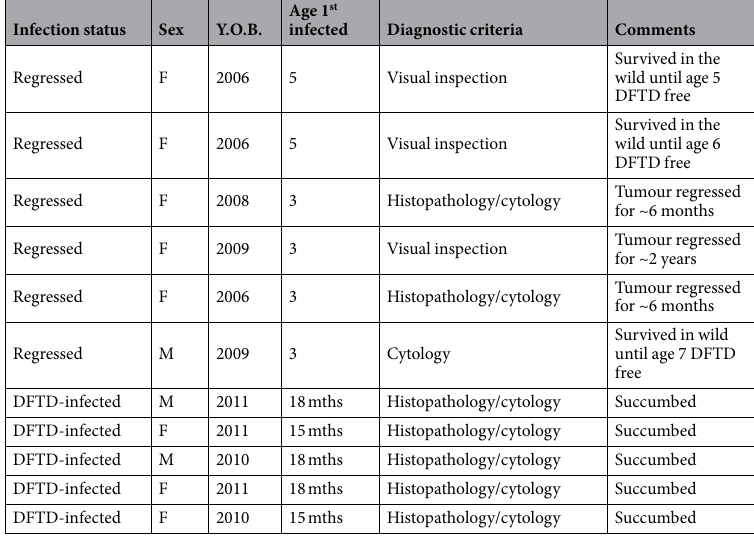
Table 3. Details of 11 West Pencil Pine samples used in the genome-wide association study. Nb. When a tumour is detected within the mouth on sampling then no biopsy or fine needle aspiration is possible therefore visual inspection scores are used to assign infection status. As sampling took place at 3 month intervals, periods of tumour regression and survival are approximate. Y.O.B. – year of birth. Ages at first infection are given in years except for those given in months